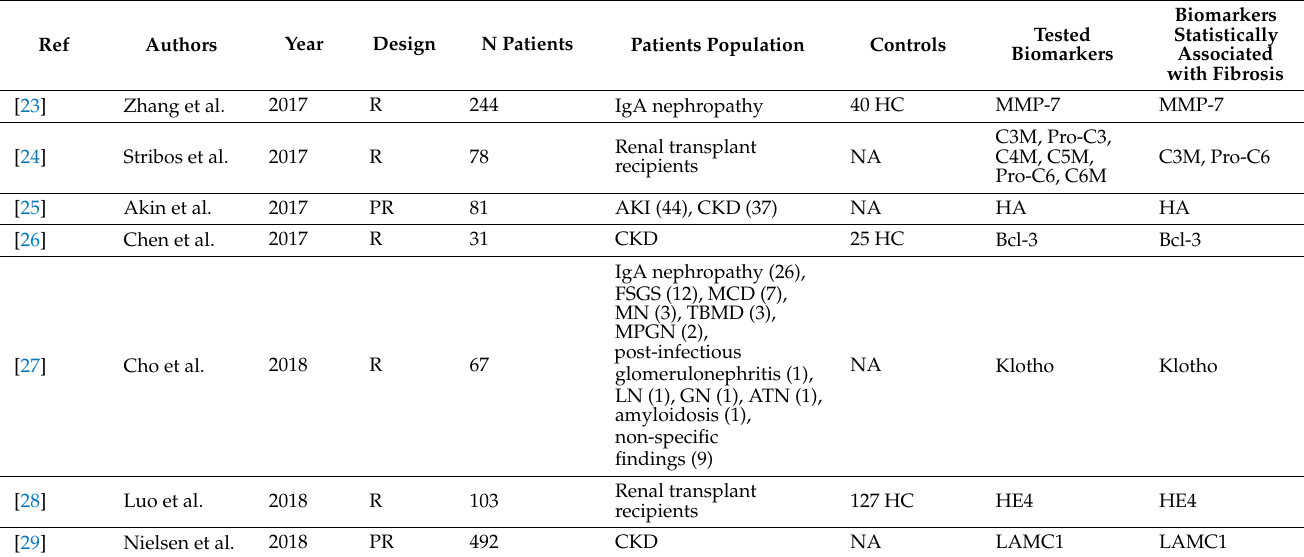
Table 1. Summary of the main characteristics of the studies included in the systematic